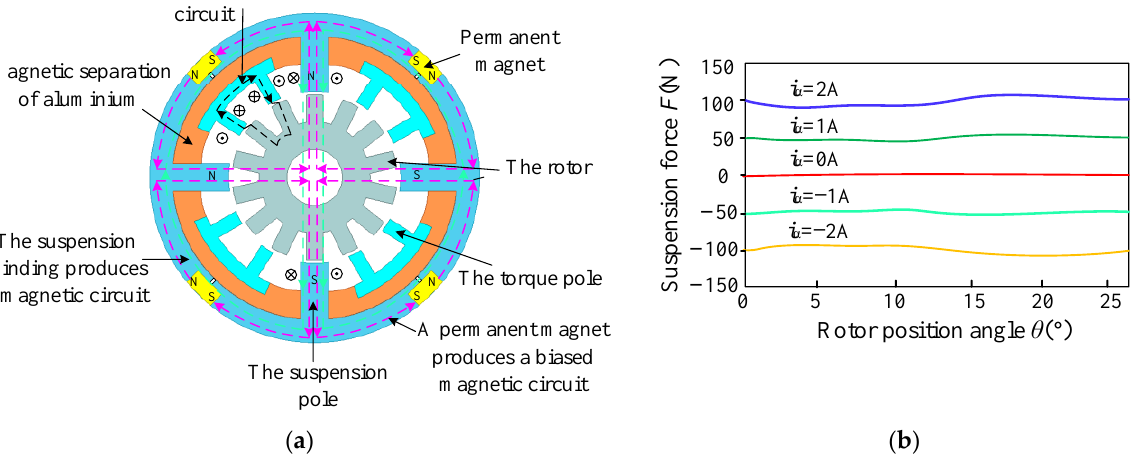
Figure 5. Permanent magnet biased hybrid stator BSRM: ( a ) Motor flux path and structure diagram; ( b ) Suspension force curve.